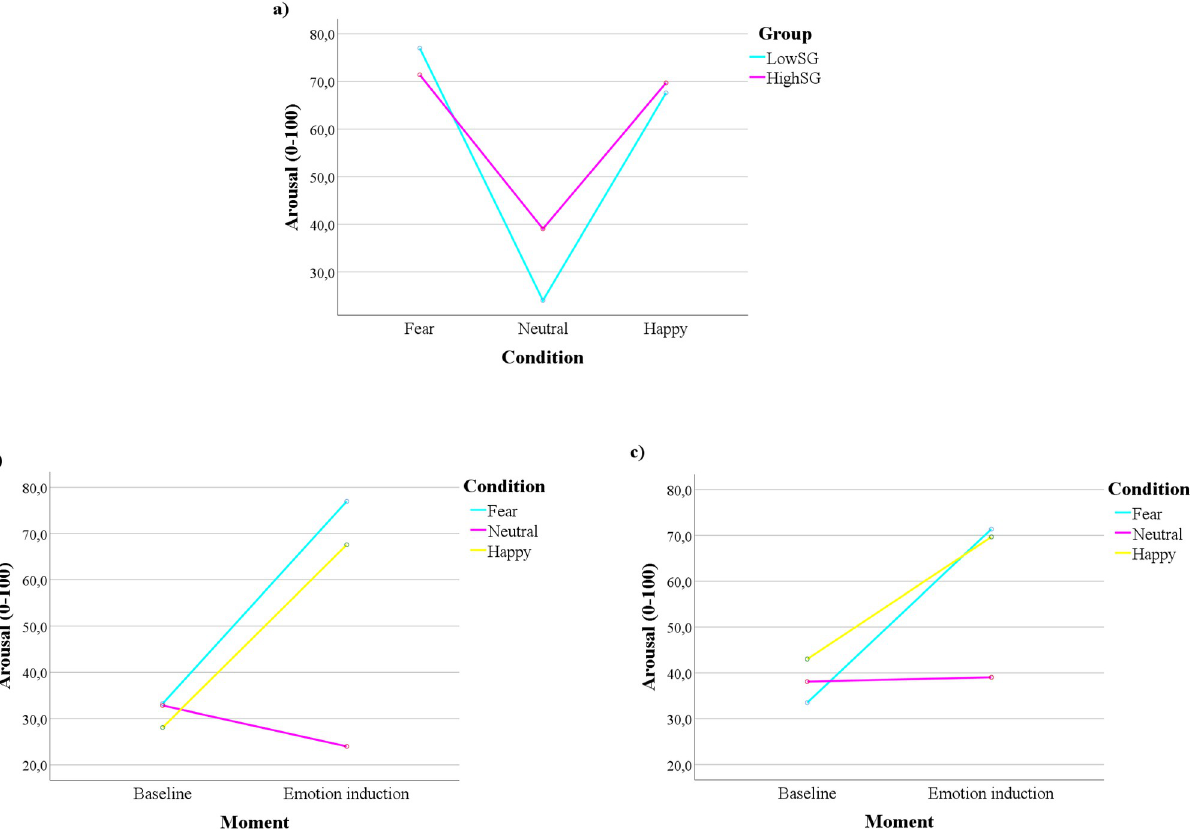
Fig 3. Somatic groups’ differences regarding the self-reported arousal. a) Group differences in the self-reported arousal after the emotional induction; b) LowSG self-reported arousal across Moment and Condition; c) HighSG self-reported arousal across Moment and Condition.